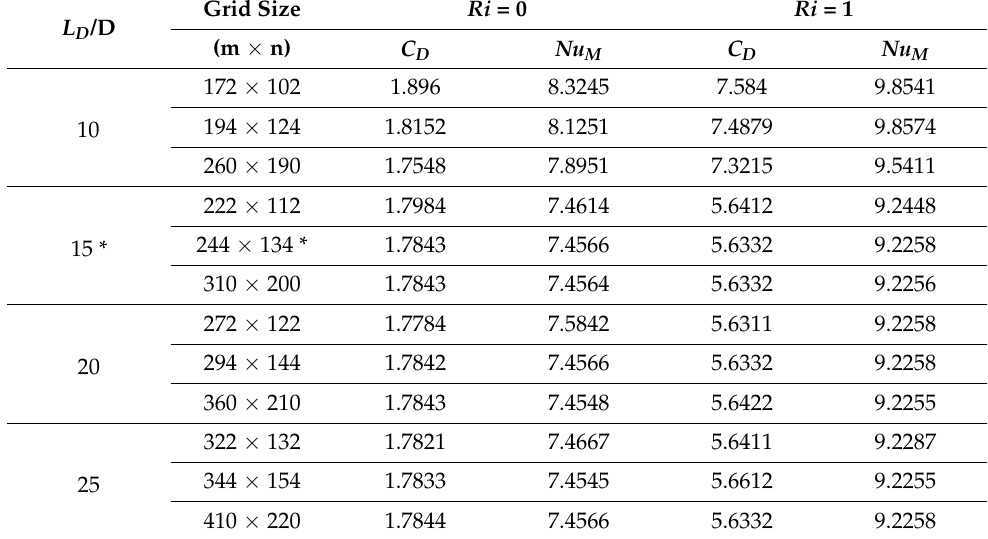
Table 2. Grid sensitivity and downstream length ( L D ) dependence test on drag coefficient ( C D ) and Nusselt number ( Nu M ) of cylinder at Re = 50 and volume fraction, ϕ = 5%. Grid Size Ri = 0 Ri = 1 L D /D (m × n) C D Nu M C D Nu M 172 × 10